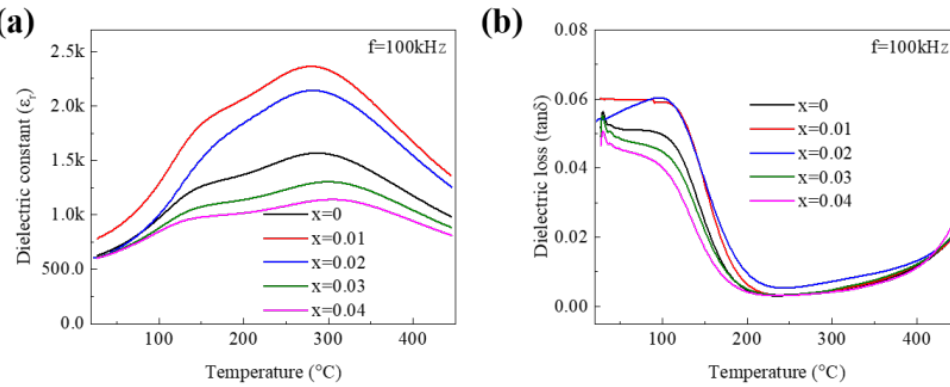
Figure 4. Temperature dependence of ( a ) dielectric constant, and ( b ) dielectric loss of porous BNBT6- xSm ceramics at 100 kHz.